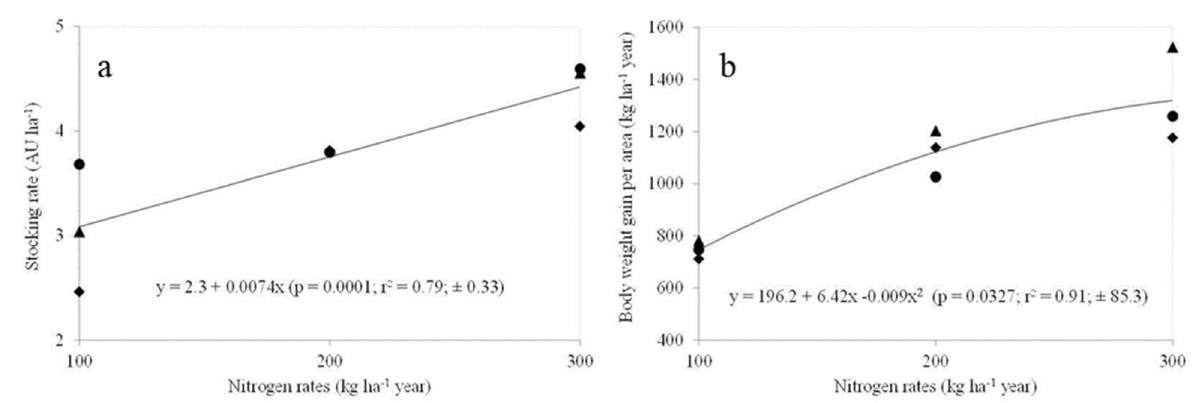
Figure 3. Effect of nitrogen on stocking rate ( a ) and body weight gain per area ( b ) in P. maximum cv. Mombaça guinea grass pastures subjected to rotational stocking and nitrogen rates ( ● year 1; ♦ year 2; ▲ year 3); (AU: Animals of 450 kg of body